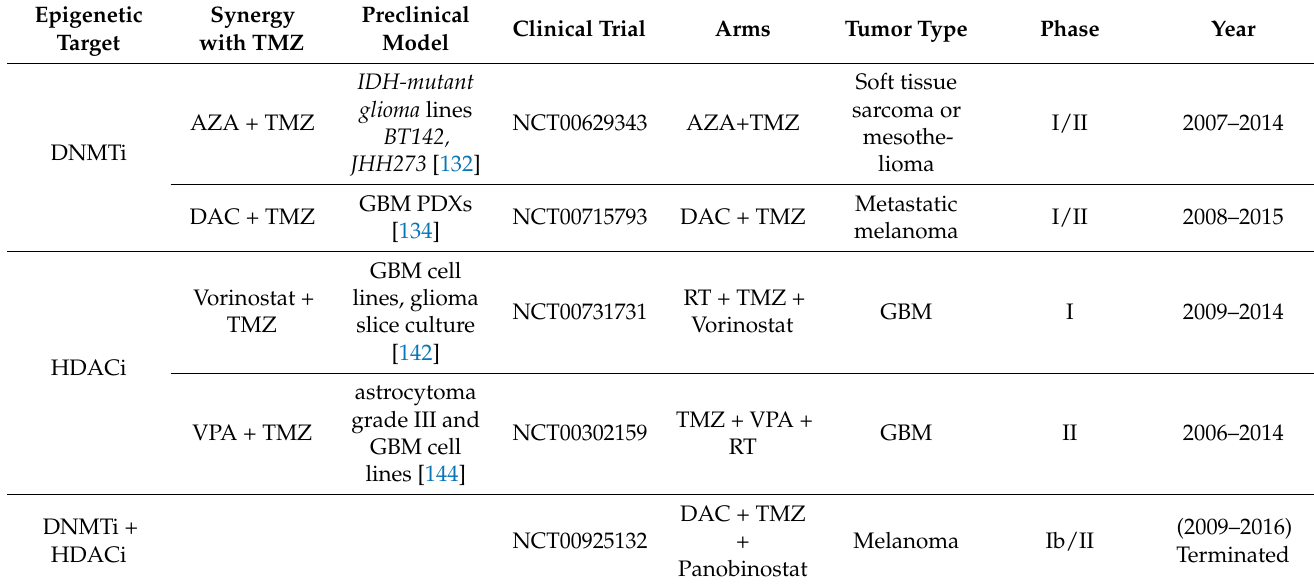
Table 3. Preclinical and clinical studies of combination therapy of epigenetic drug with TMZ.